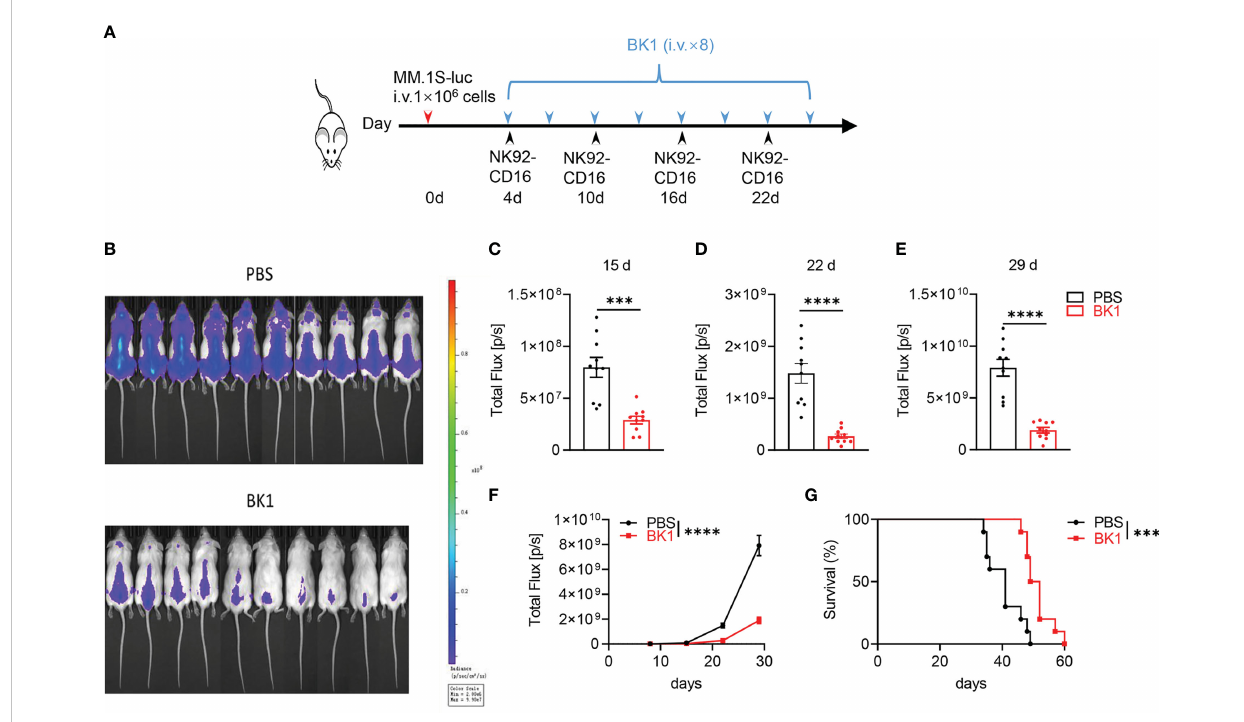
FIGURE 3 BK1 treatment inhibits tumor growth in an NK92-CD16 cell-reconstituted xenogeneic tumor model. (A) Experimental protocol for the tumor model used in (B – G) : NSG mice (n = 10/group) were injected intravenously (i.v.) with MM.1S-luc tumor cells (1 × 10 6 ) on day 0 followed by intravenous injection of NK92-CD16 cells (2 × 10 6 ) on day 4 and every 6 days for a total of 4 times. Tumor-bearing mice were injected intravenously (i.v.) with BK1 or PBS (50 m g/mouse) every 3 days for a total of 8 doses beginning on day 4. (B) In vivo bioluminescence imaging of mice 22 days after tumor challenge described in (A) . (C – E) Quanti fi cation of luminescence in PBS-treated or BK1-treated mice on days 15, 22 and 29. (F) Luminescence in PBS-treated or BK1-treated mice on days 8, 15, 22 and 29. (G) Overall survival of PBS-treated and BK1-treated mice. Each symbol (C – E) represents an individual mouse. Data were analyzed by Student ’ s t test (C – E) , 2-way analysis of variance (F) and the Mantel-Cox test (G) , ***P < 0.001, ****P <